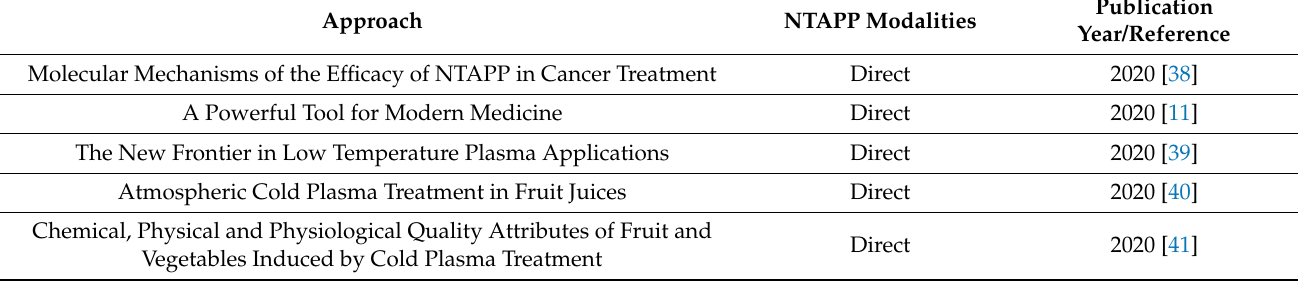
Table 1. Summary of the main review articles published in the last three years on applications of direct and indirect